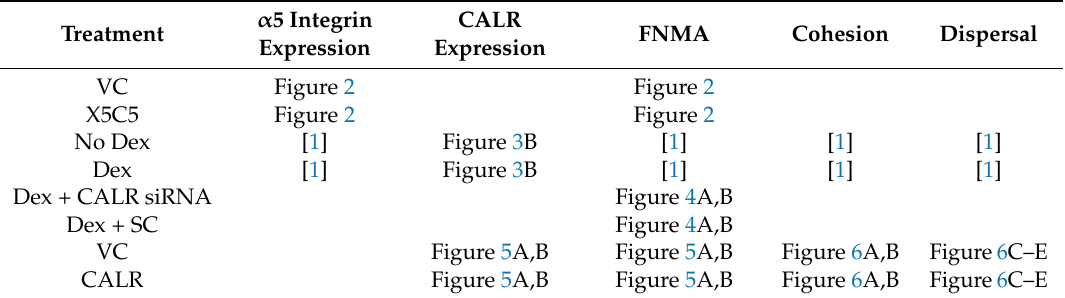
Table 1. Summary table of the kinetics of CALR, InsFn (FNMA), Integrin-5, cohesion, and dispersal in response to Dex